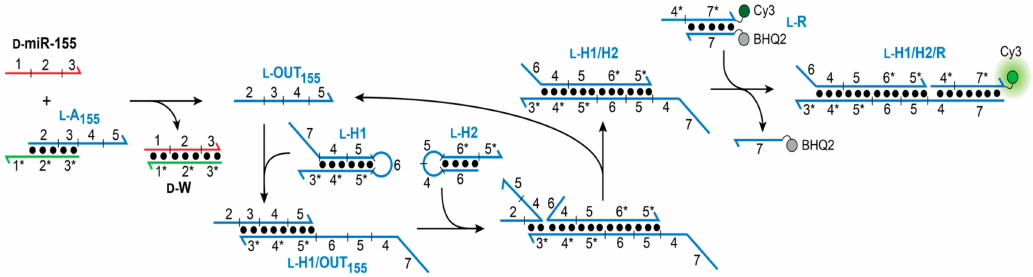
Figure 2. Schematic illustration of the heterochiral l -CHA circuit. Sequences of all strands are listed in Table S1. d -MiR-155 RNA is colored